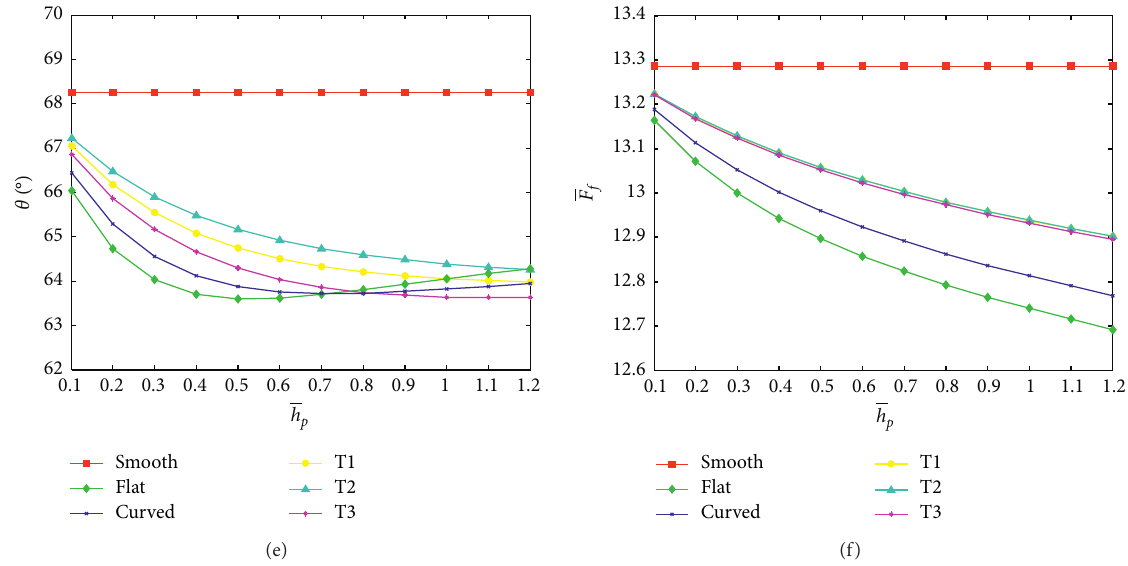
Figure 7: Effect of the texture depth on static performance characteristics for smooth/textured journal bearings: (a) the load-carrying capacity ( W ); (b) the maximum fluid film pressure ( P ); (c) the friction coefficient ( f ); (d) the end leakage flow rate ( Q z ); (e) the attitude max angle ( θ ); (f) the friction force ( F f ). Bearings are lower than that of smooth bearing in the texture depth ( h y ) ranges. However, the end leakage flow rate ( Q Z ) keeps increasing and the friction force ( F f ) keeps decreasing,